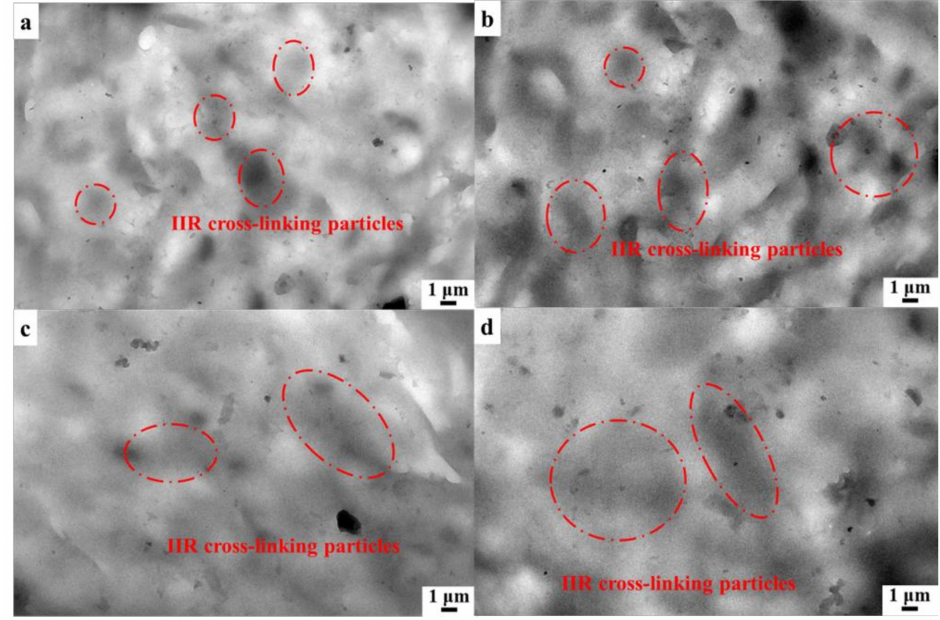
Figure 8. TEM micrographs of IIR/PP-TPV samples with different recycling times: ( a ) 0 times, ( b ) 1 time, ( c ) 3 times, and ( d ) 4